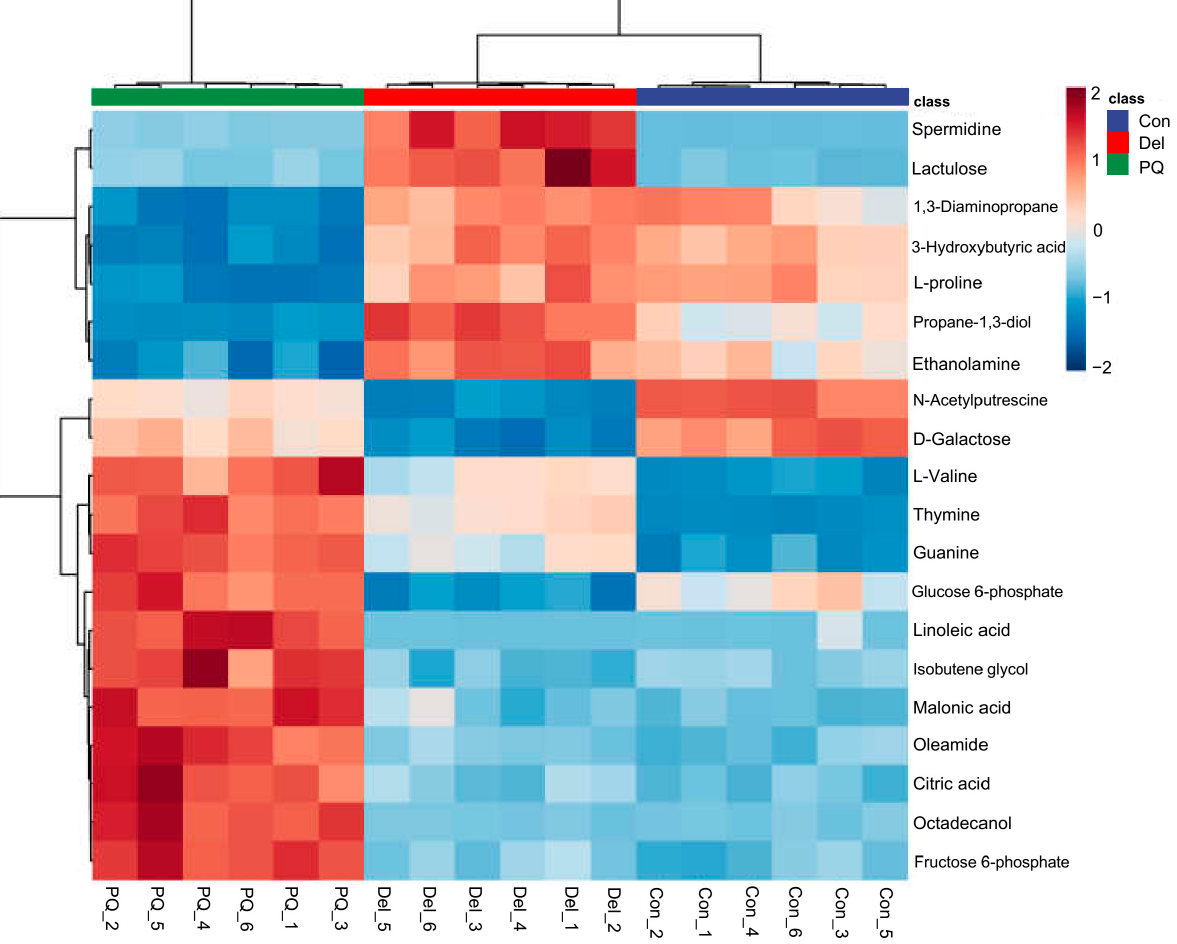
Figure 4. Heat map of the cluster analysis of the first 20 differential metabolites of A549 cell treated with PQ and Del. These differential metabolites were screened with FC > 1.2 and p < 0.05.